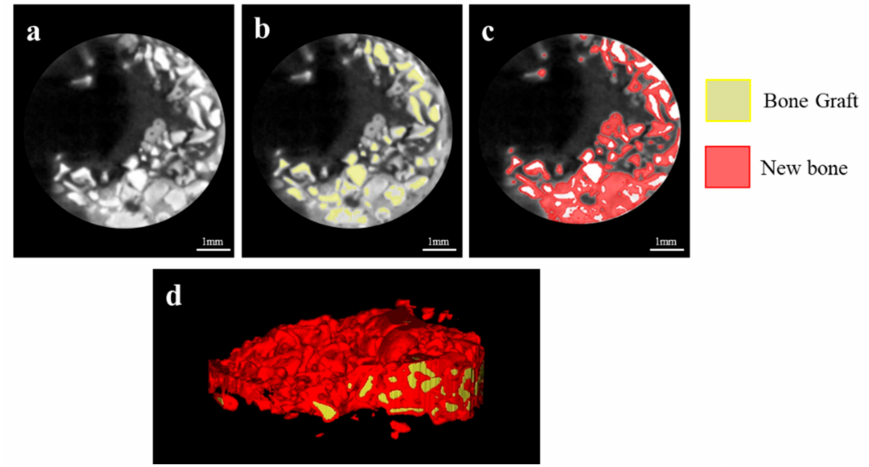
Figure 13. Images within ROIs obtained by micro-computed tomography analysis. ( a ) Two- dimensional micro CT image; colored images of ( b ) grafted bone scaffold and ( c ) new bones. ( d ) Con- verted 3D image for adjudging external appearance.